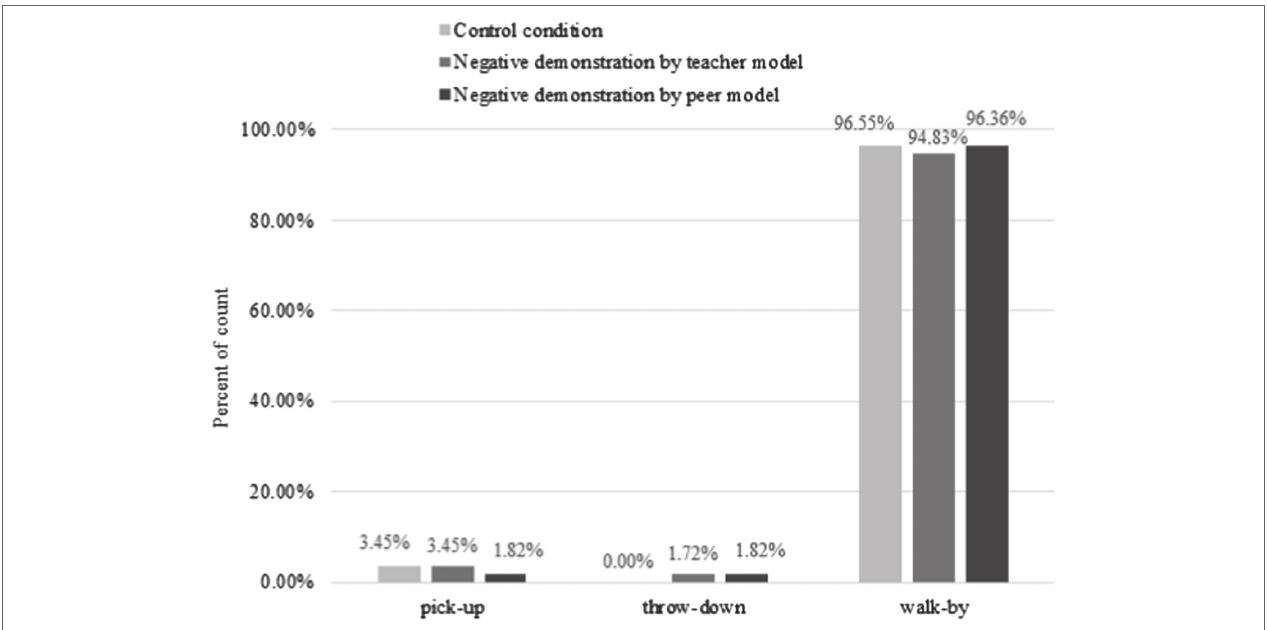
FIGURE 2 | Percentage of subjects engaging in the three target behaviours in the Control, NDTM, and NDPM